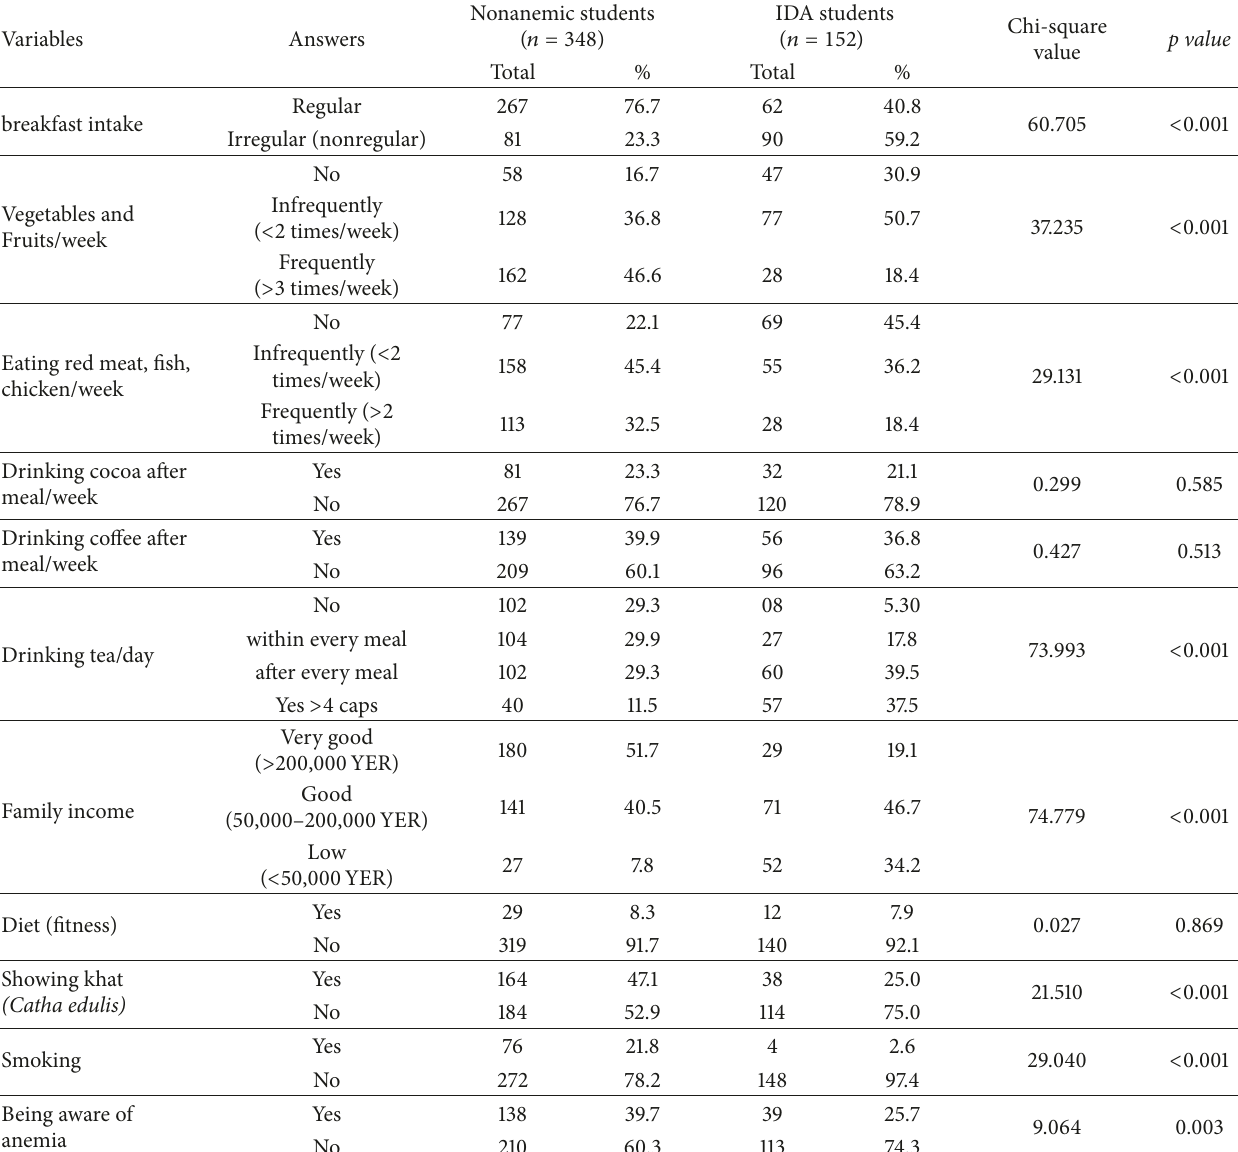
Table 2: Distribution of anemic (IDA) and nonanemic students according to risk factors (social habits).